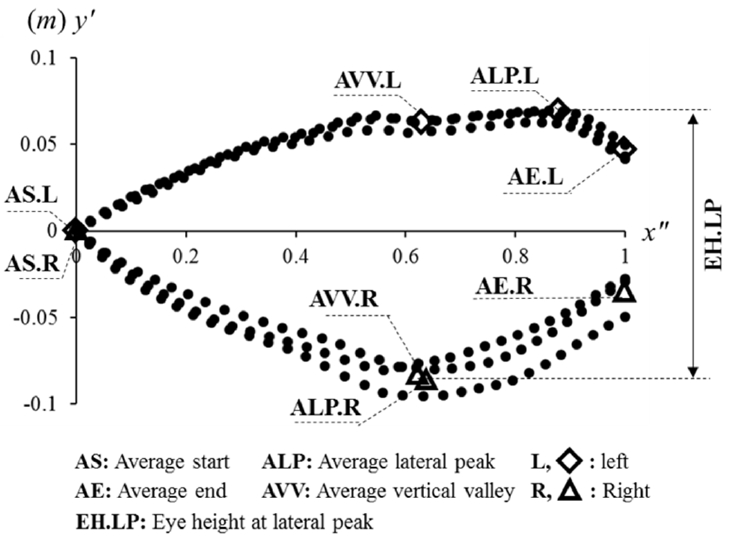
Figure 5. Normalized head unit trajectories of six steps on the transverse plane ( x ″ -y ′ coordinate system; x ″ : 0.0 – 1.0), also called the gait eye diagram at the head type-II (GE-H II).